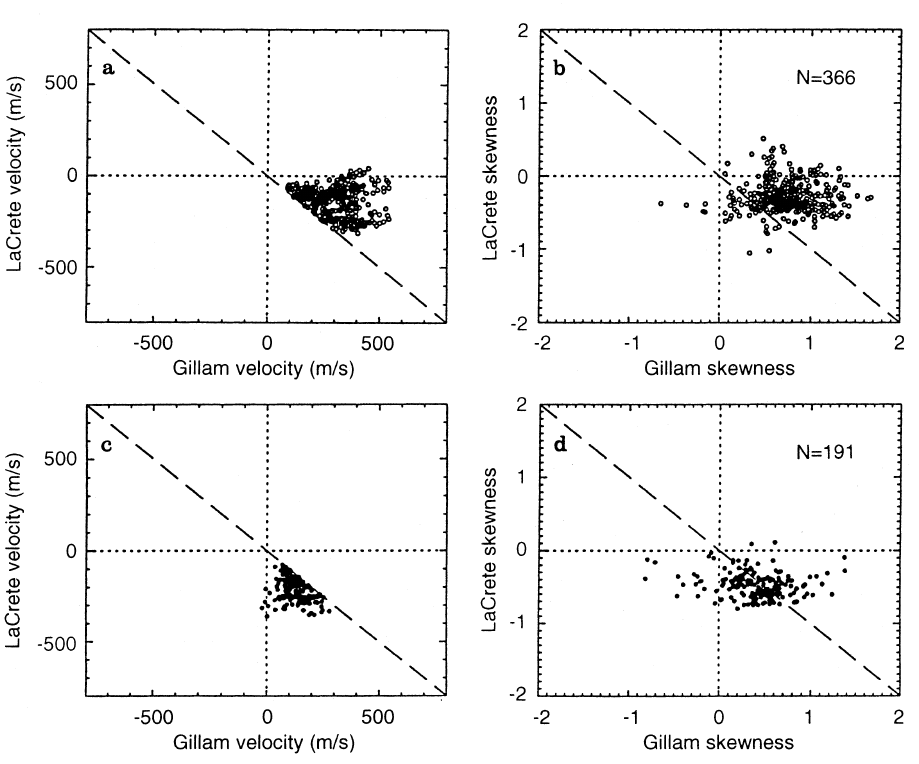
Fig. 5a–d. Scatterplot of skewness at the LaCrete-Saskatoon link ver- sus skewness at the Gillam-Saska- toon link: b For the cases when the mean electron flow was closer to the Gillam-Saskatoon link bisector as shown in a ; d For the cases when the mean electron flow was closer to the LaCrete-Saskatoon radio link as shown in